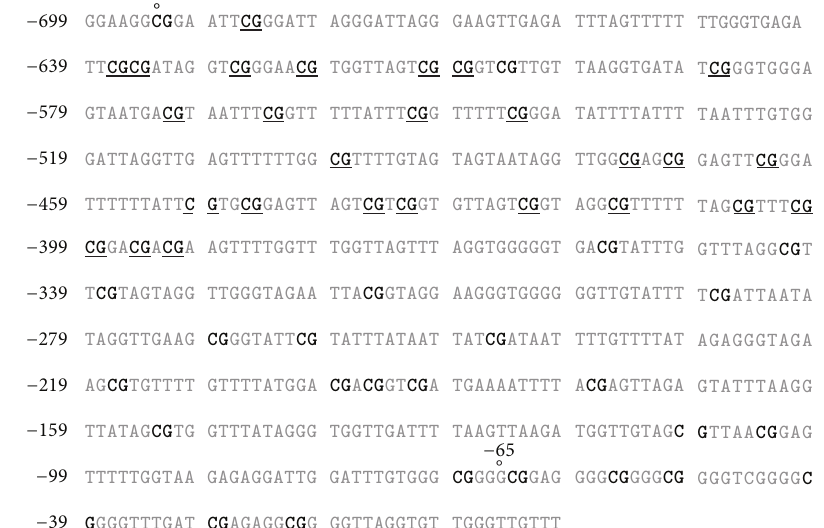
Figure 1: VDR methylated sites of VDR promoter region from − 693 to − 65 bp in one representative adrenocortical carcinoma, analyzed by bisulfite sequencing. In DNA sequence, bold types indicate all CpG dinucleotides, and underlined CpG indicate methylated